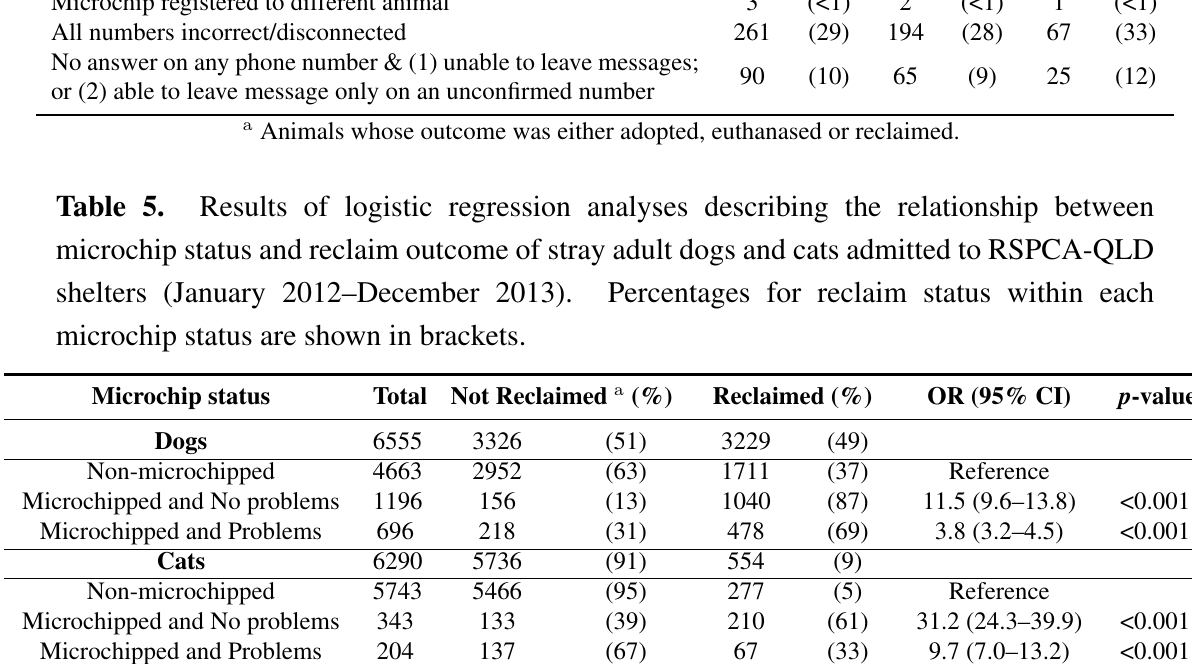
Microchipped and